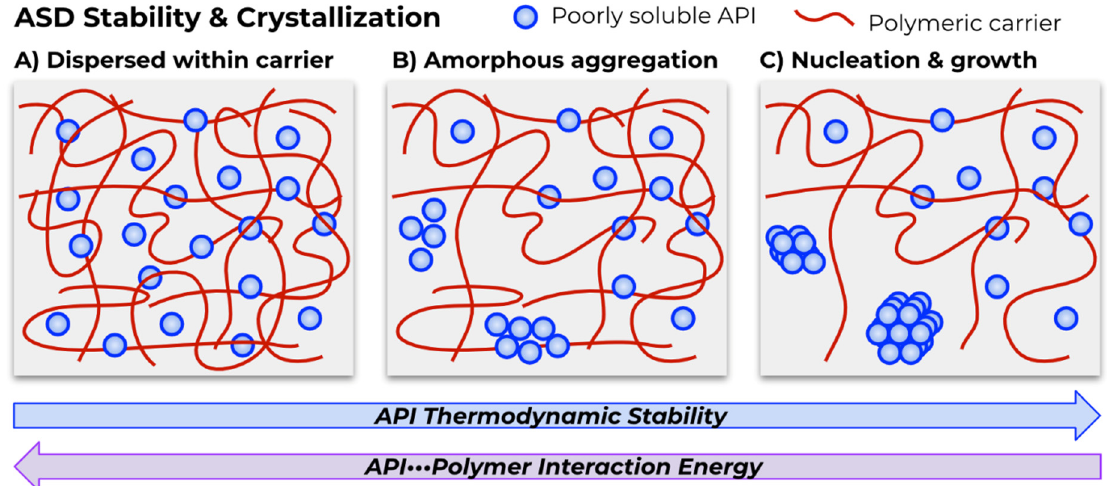
Figure 2. ( a ) Thermodynamic stabilization from API–polymer non-bonding interactions promotes API dispersion throughout the polymer carrier matrix. ( b ) Molecular mobility can lead to increased API–API interaction and aggregation. ( c ) Small sites of local aggregation and nucleation can grow to larger API crystals incurring reduced solubility.